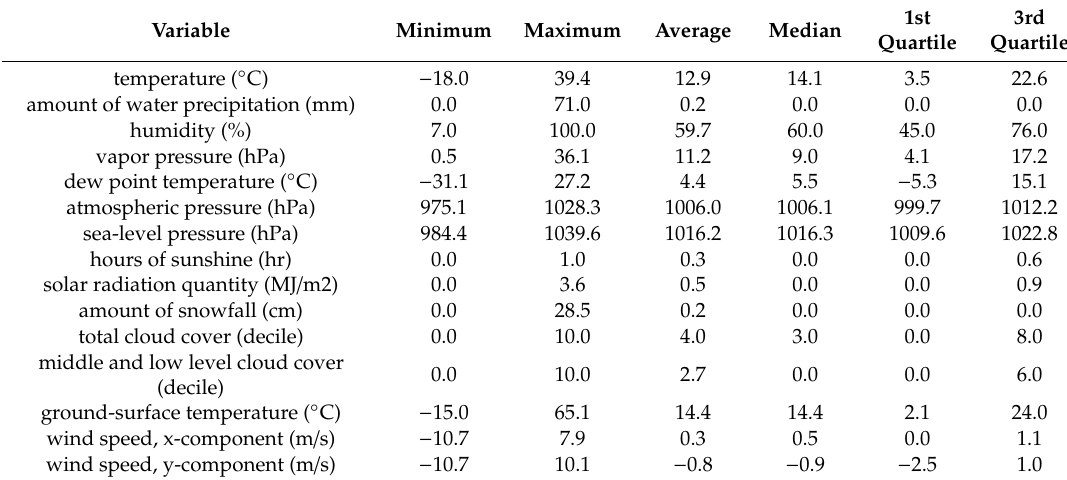
Table 8. Basic statistics for hourly data in metropolitan area (Seoul).